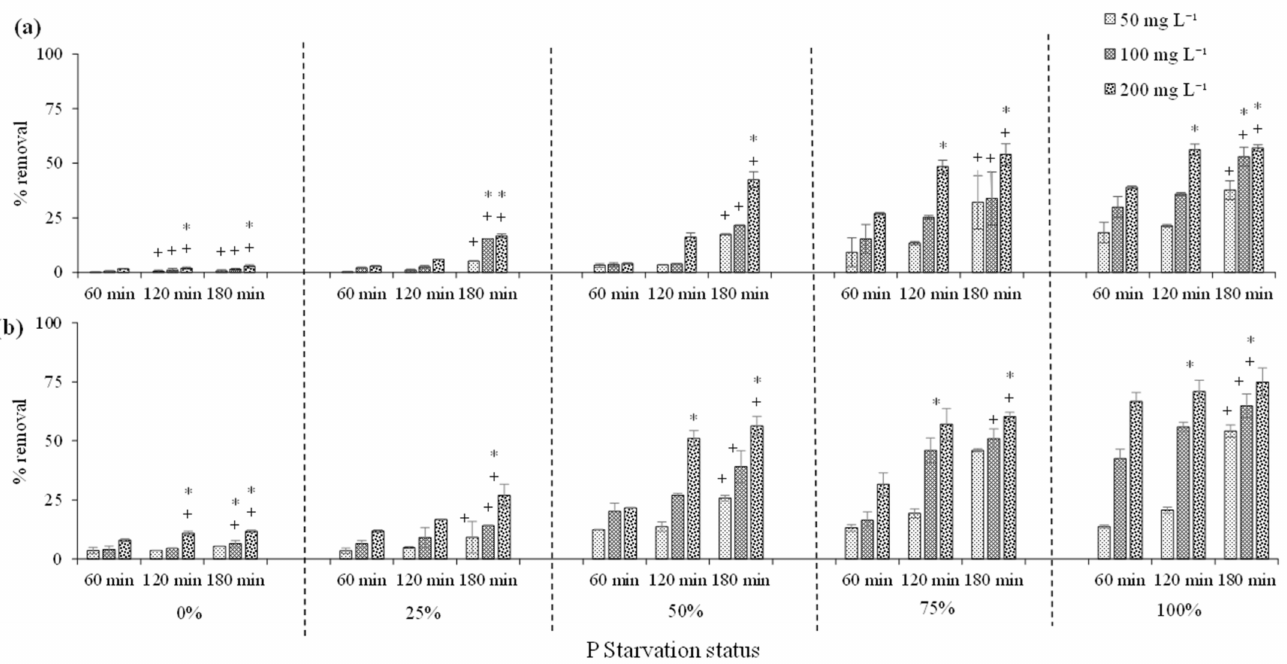
Figure 3. Percent removal of 2-chlorophenol by C. vulgaris dried biomass starved with 0, 25, 50, 75, 100% phosphorus at ( a ) 70 mg L − 1 and ( b ) 150 mg L − 1 2-chlorophenol exposure. In